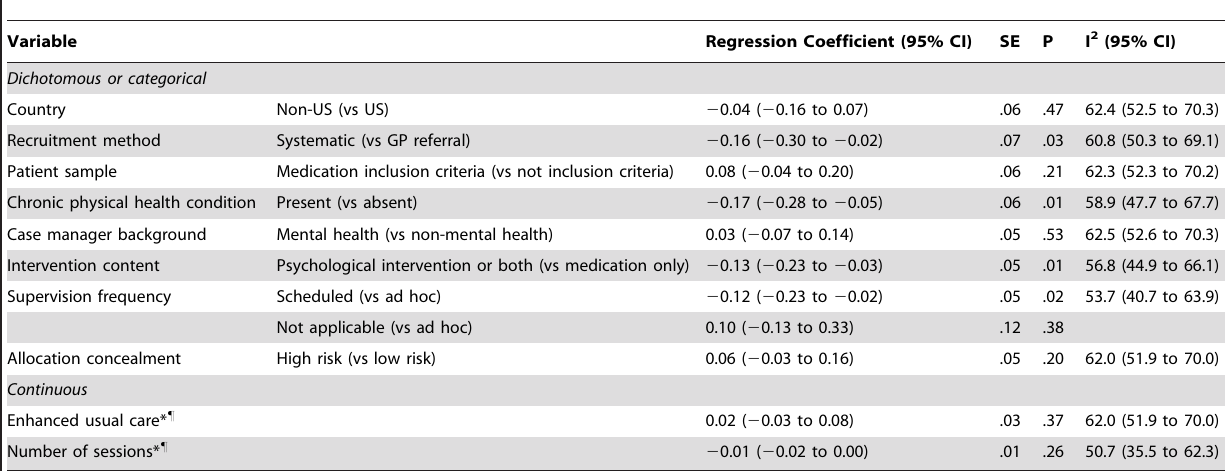
Table 4. Univariable predictors on depressive symptoms